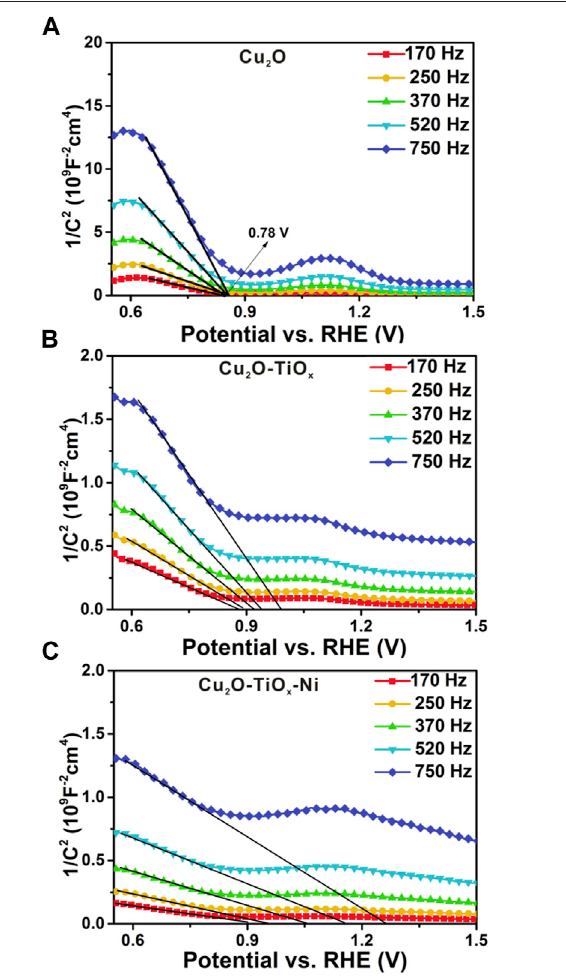
FIGURE7| Mott – Schottkyplots (A – C) for baredCu 2 O, Cu 2 O/TiO x ,and Cu 2 O/TiO x /Ni photocathodes, respectively. Measurements performed from 0.0 to 1.0 V vs. Ag/AgCl in pH = 6.0 0.5 M potassium phosphate buffer using multi-sine staircase potential impedance